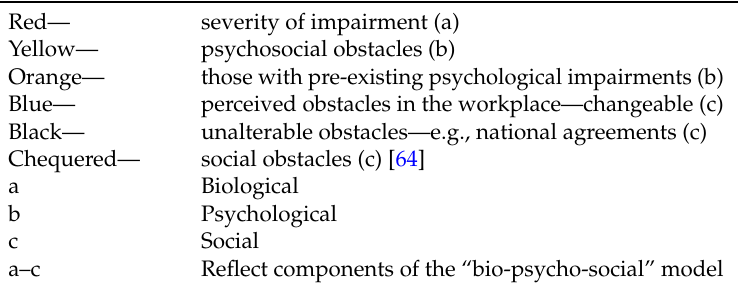
Table 2. The flag system of obstacles inreturning to work